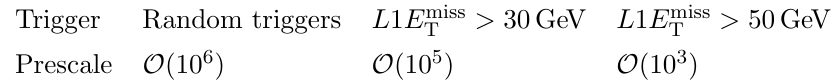
acceptance model with T